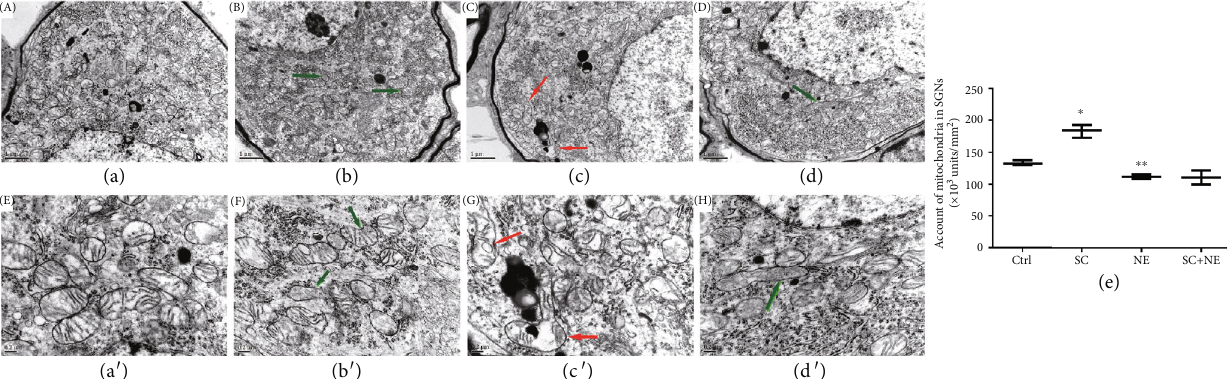
Figure 3: Ultrastructural changes of spiral ganglion neuron. Electron transmission micrographs for SGNs in the control group (a/a ′ ), sound conditioning group (b/b ′ ), noise exposure group (c/c ′ ), and sound conditioning and noise exposure group (d/d ′ ). Green arrows showed that sound conditioning could enhance the electron density in the mitochondrion of spiral ganglion neuron cells and narrow the interspace of the mitochondrion. Red arrows indicated that noise exposure could result in the destruction of the mitochondrion in SGNs, the lower electron density, larger interspace, and the formation of the vacuole in the mitochondrion. Scale bars represent 1 μ m and 0.2 μ m. The account of a mitochondrion in spiral ganglion neuron cell of SD rat presented in (e) was analyzed with one-way ANOVA ( F = 55 : 17 ; P < 0 : 0001 ), followed by Newman-Keuls ’ post hoc test ( × 10 3 units/mm 2 , n = 6 pictures from 3 animals/group, mean ± SD ; Ctrl vs. NE: ∗∗ P < 0 : 05 , SC vs. Ctrl: ∗ P < 0 : 05